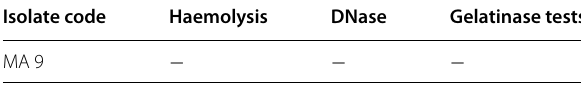
Table 2 Safety assessment of the bacteria isolate (MA9) with the highest